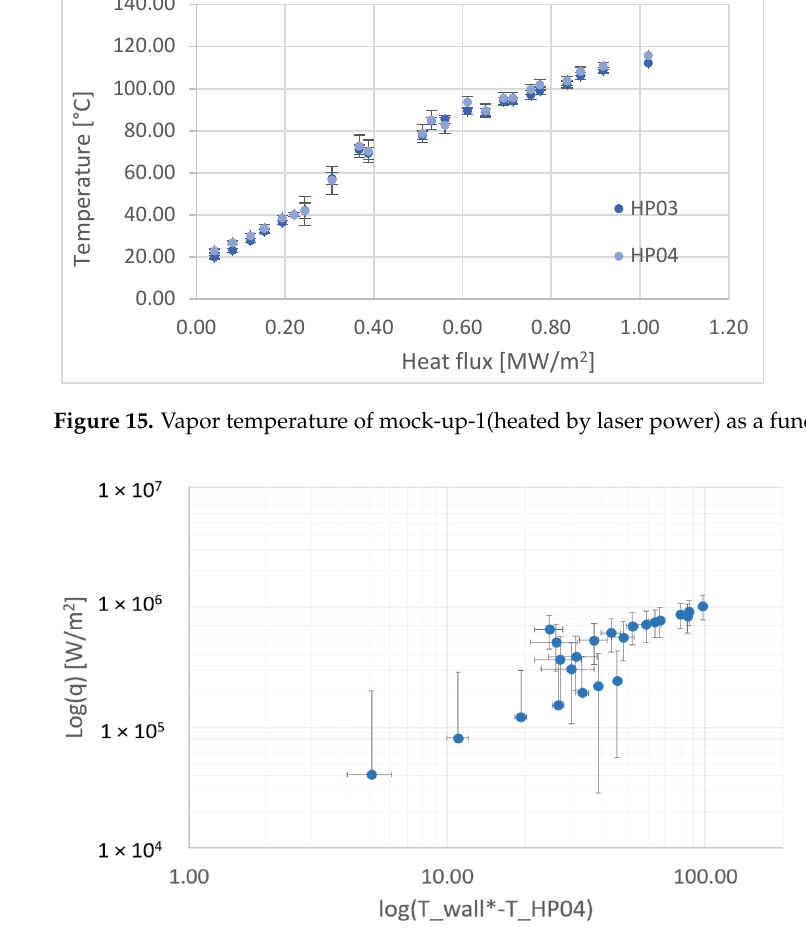
Figure 16. Heat flux versus average wall superheated Δ T of mock-up 1 with laser.